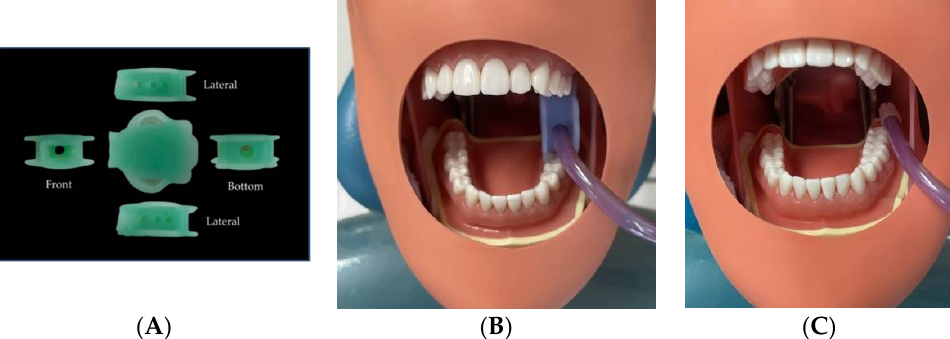
Figure 2. ( A ) The dental mouth prop with the suction holder device (Thai Patent No: 19329, Thai FDA No: 64-1-3-2-0000523). ( B ) The location at which the dental mouth prop with a suction holder attached to the saliva ejector was placed in the typodont manikin head. ( C ) The location at which the saliva ejector was placed.